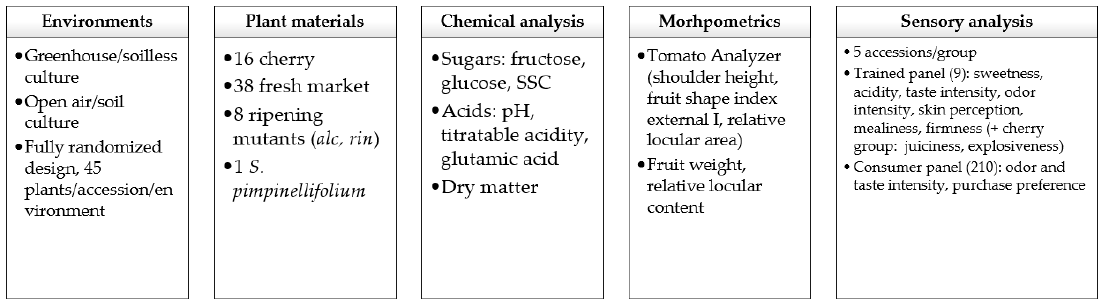
Figure 1. Graphical scheme with the experimental design and traits